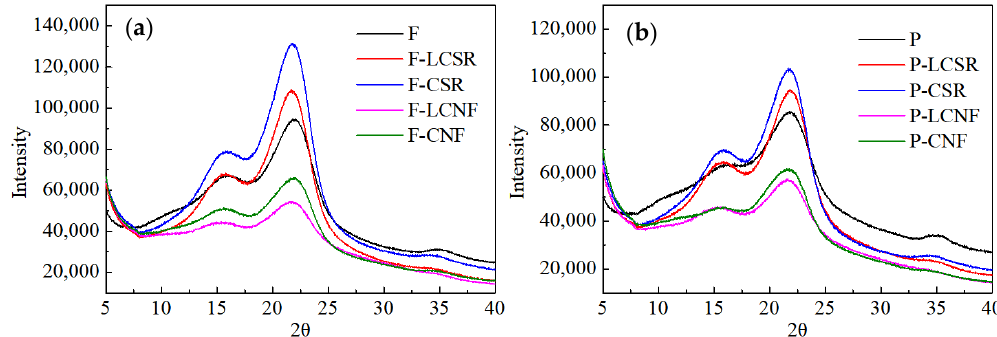
Figure 5. XRD patterns for the raw materials and their corresponding (L)CSR and (L)CNF samples from fibers ( a ) and parenchyma cells ( b ).